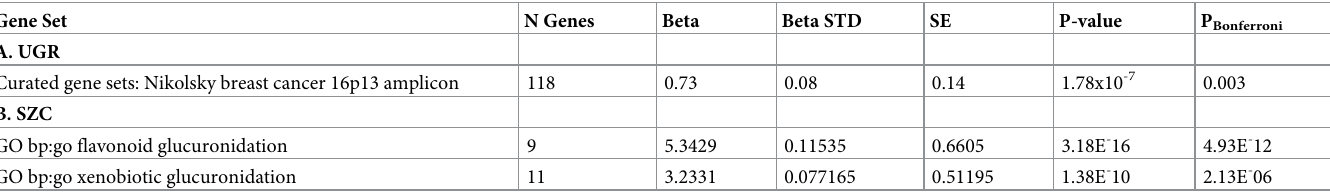
Table 3. MAGMA gene set